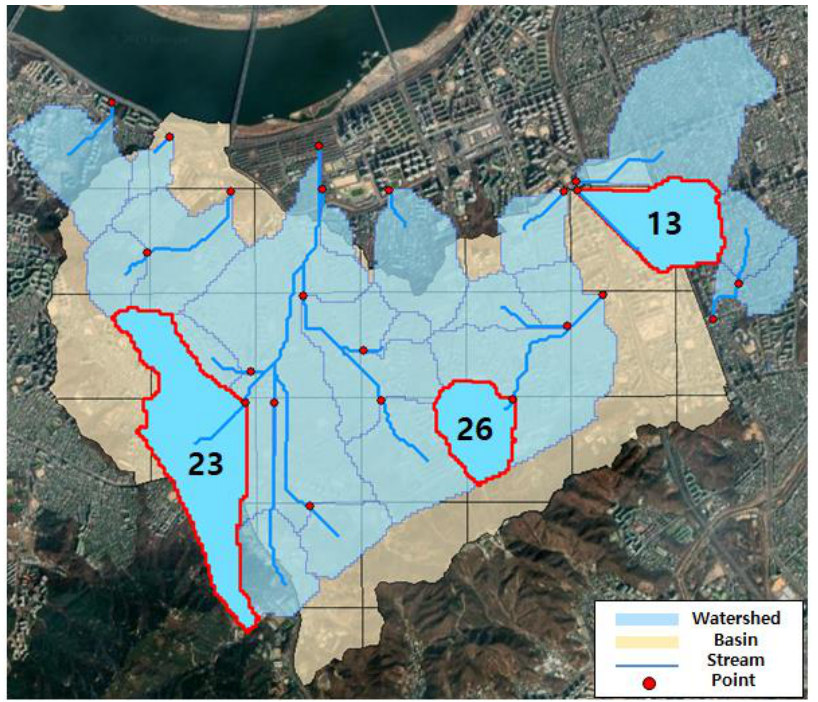
Figure 11. Basin for runoff model.